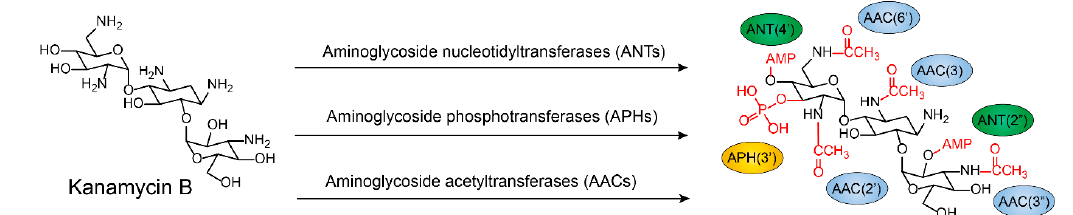
Figure 4. Modification of kanamycin B by aminoglycoside nucleotidyltransferases (ANTs), phosphotransferases (APHs), and acetyltransferases (AACs) [87–91].